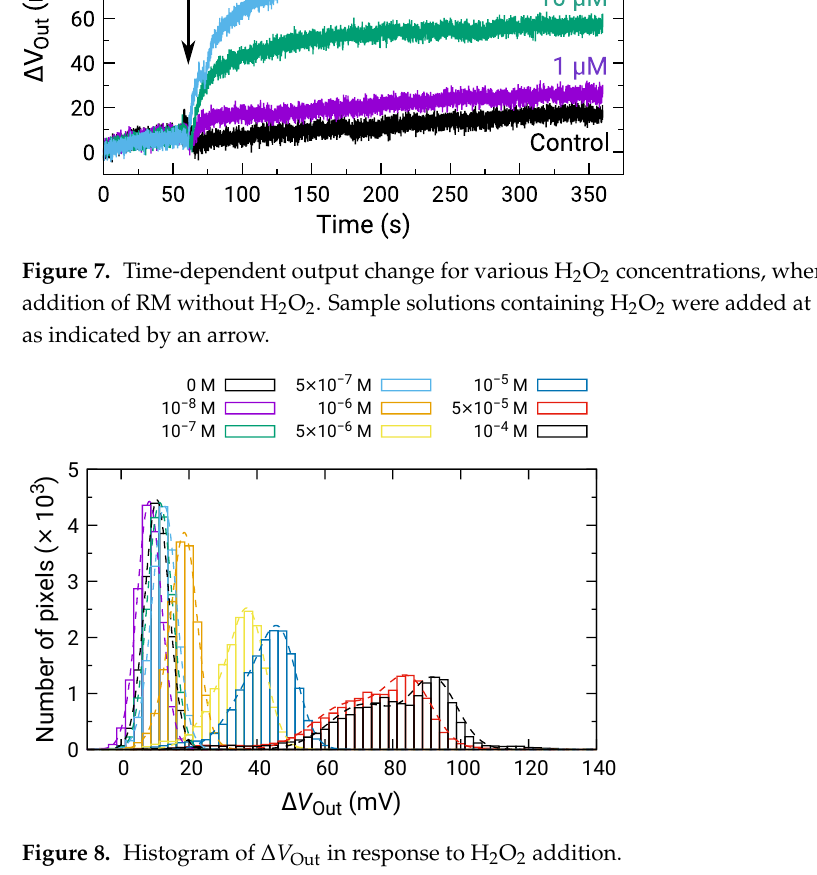
Figure 8. Histogram of ∆ V Out in response to H 2 O 2